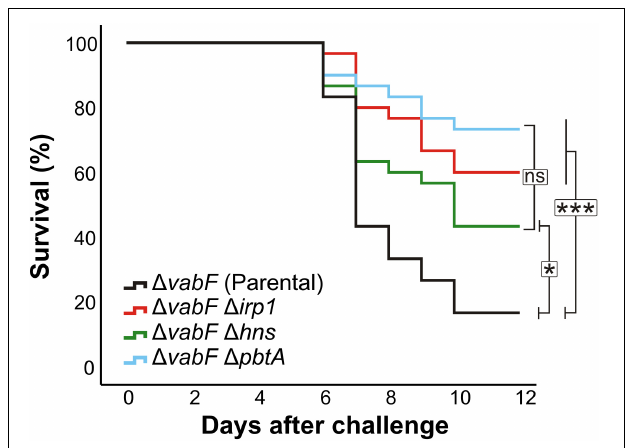
FIGURE 4 | Survival abilities (Kaplan–Meier survival functions) of fish infected with the V. anguillarum pbtA − (RV22 (cid:49) vabF (cid:49) pbtA ) or h-ns − (RV22 (cid:49) vabF (cid:49) h-ns ) strains compared to parental strain (RV22 (cid:49) vabF ) and the non-siderophore producer strain RV22 (cid:49) vabF (cid:49) irp1 . Asterisks denote statistical significance, * p < 0.05; *** p < 0.001, ns, no statistically significant